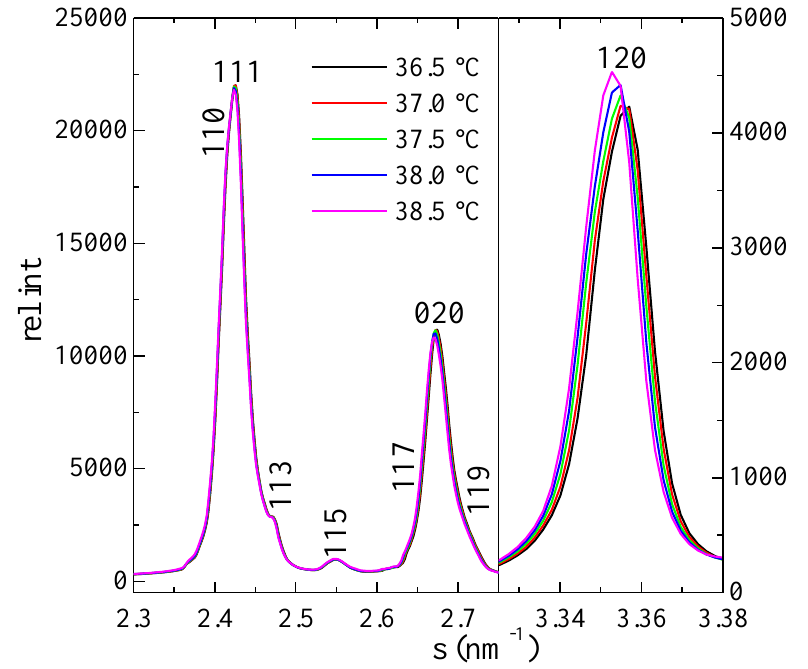
Figure 4. Selected regions of the WAXS diffractograms for sample C 23 H 48 at the indicated temperatures covering the δ transition. The Miller indices are specified (note that a and b axes are interchanged in relation to polyethylene).